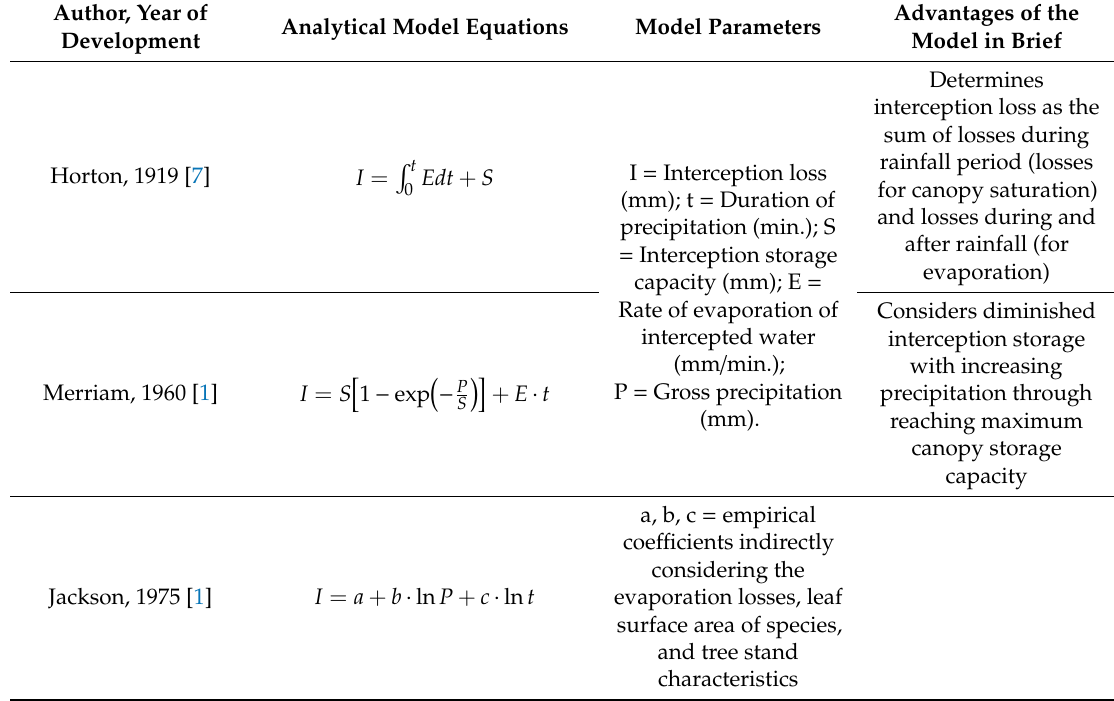
Table 1. Features of existing models of rainfall interception by tree stand